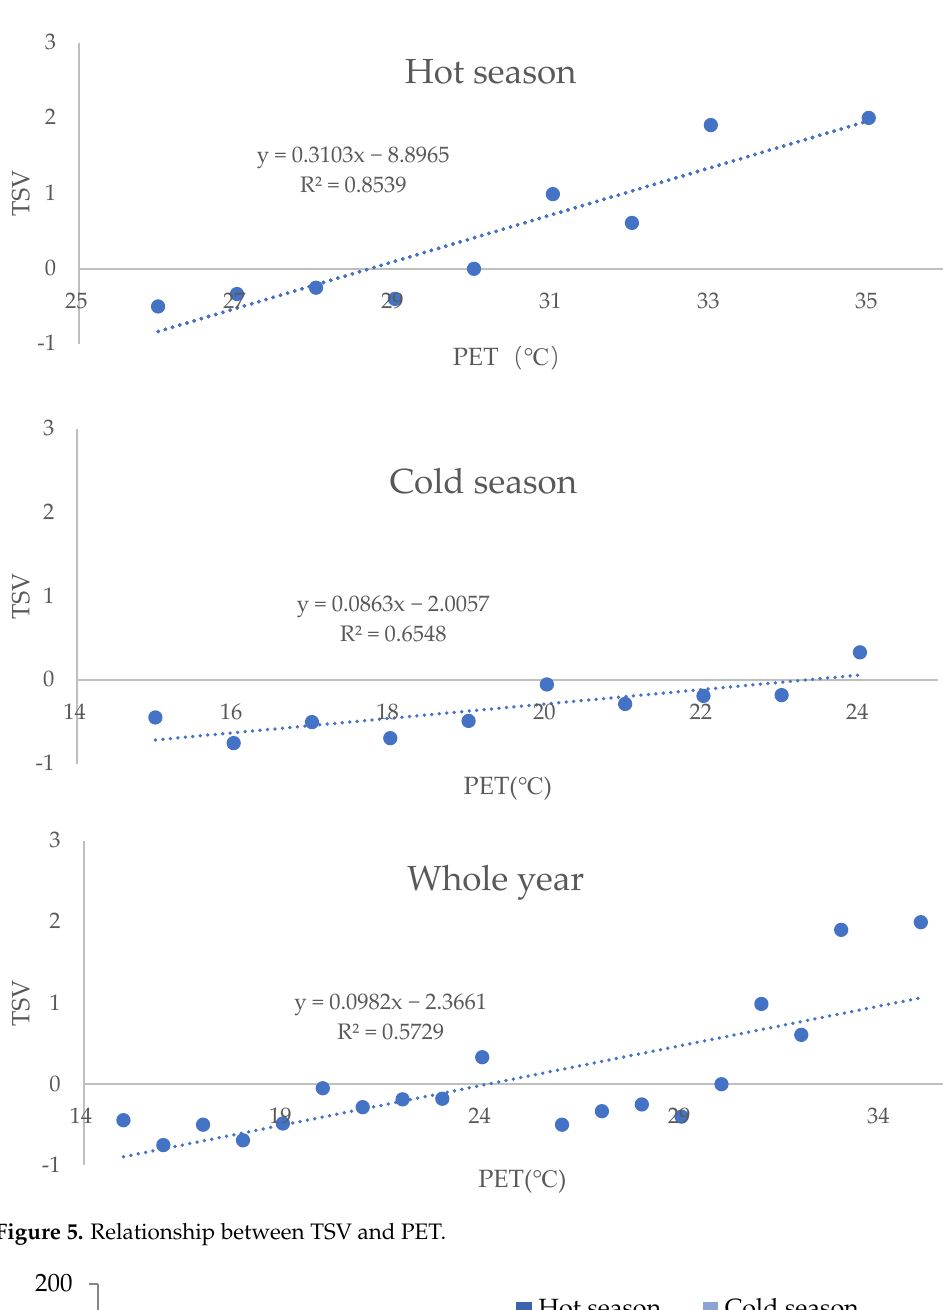
Figure 5. Relationship between TSV and PET.